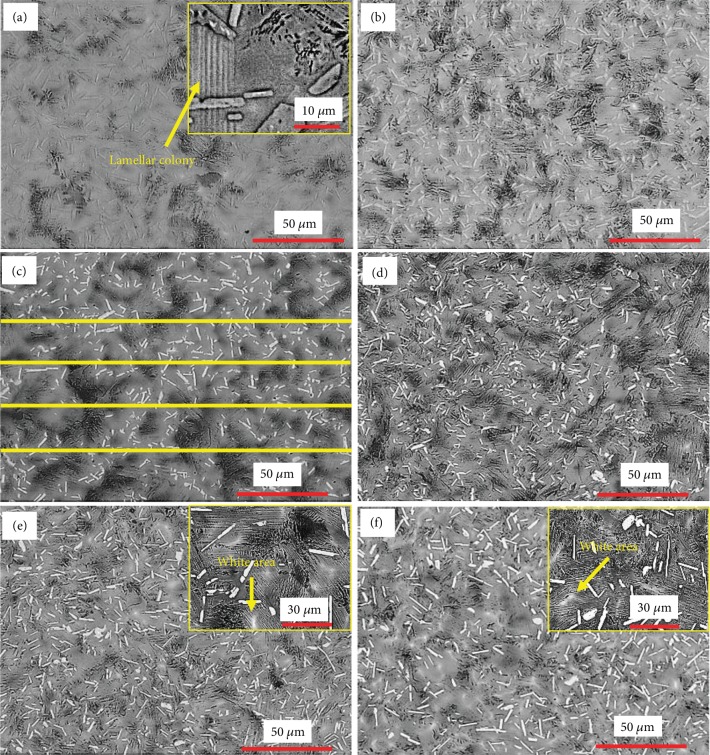
SEM images of the Ti46Al8Nb2.6CxTa alloys: (a) zero; (b) 0.2 at.%; (c) 0.4 at.%; (d) 0.6 at.%; (e) 0.8 at.%; (f) 1.0 at.%.